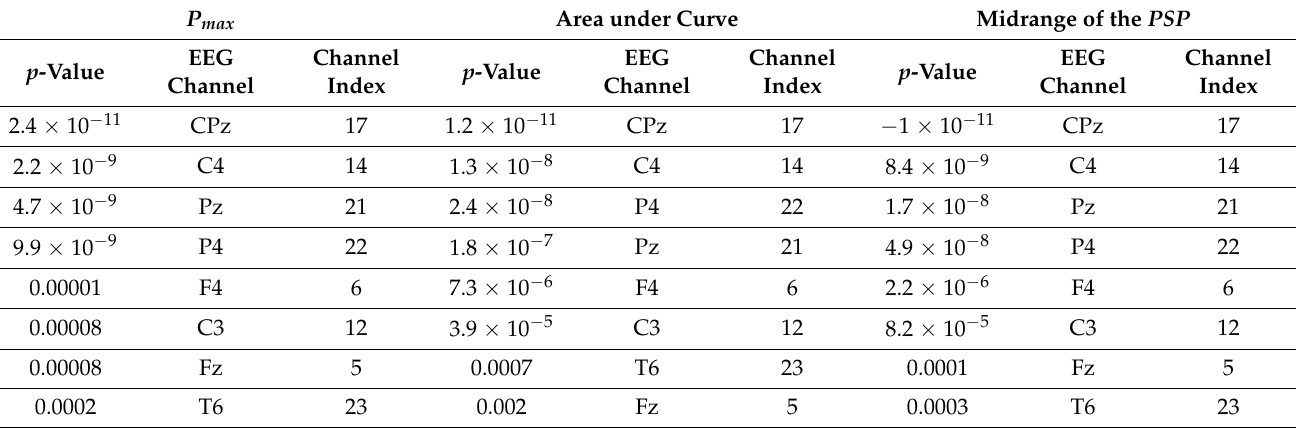
Table 1. A t -test measure was applied to the P max (left), the area under the curve of PSP (middle) and the midrange of the PSP (right) to identify how two classes control and OP are statistically significant. Among these eight top EEG channels, channel 17 has the lowest p -value, representing the highest discriminative power between the samples from different classes. P max Area under Curve Midrange of the PSP p -Value